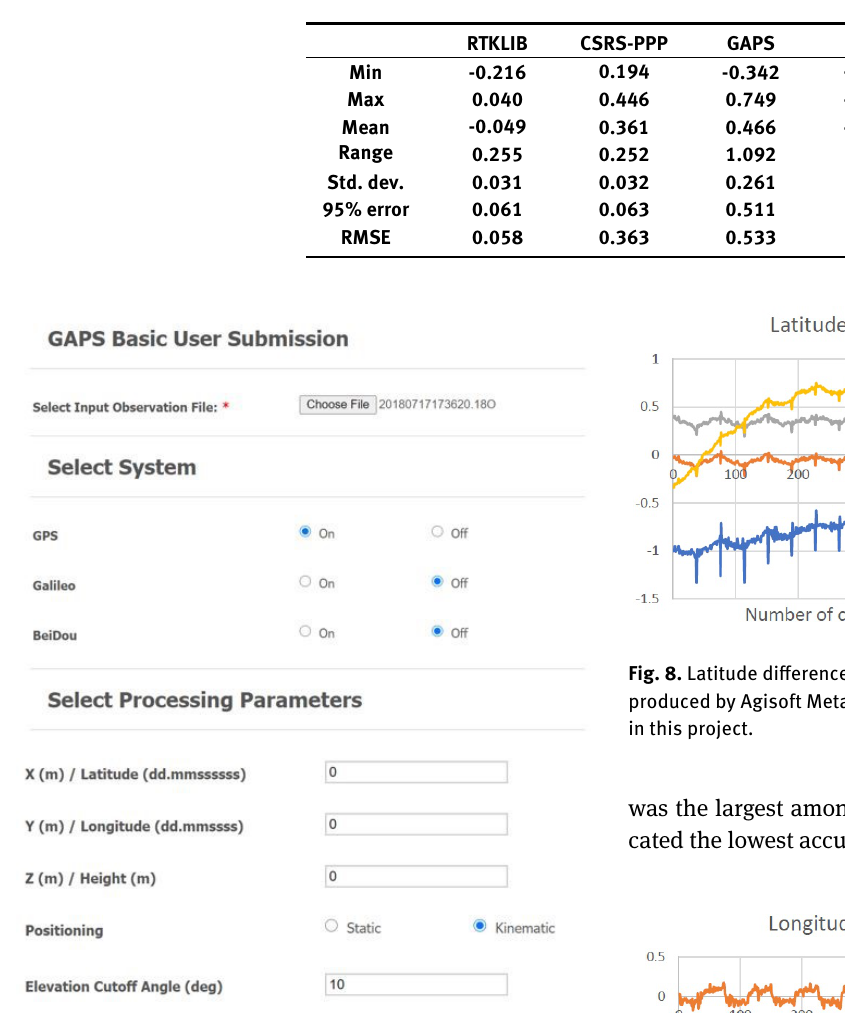
In Table 2, RTKLIB produced the best results in terms of longitude values. Negative bias was present in the CSRS- PPP results. Small standard deviation showed high mea- surement precision. Yet, RMSE of 0.539 hinted at the pres- ence of outliers in the data. GAPS results displayed upward and downward trends. Negative bias was also present in GAPS results. By looking at standard deviation and RMSE values, it was deduced that the results were neither as